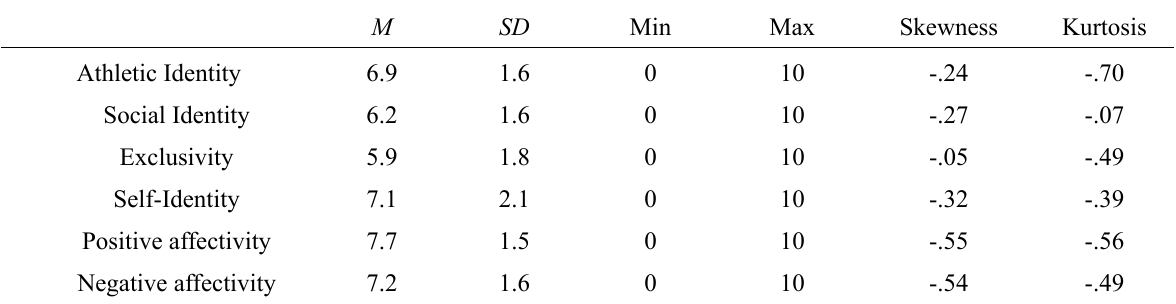
Descriptive Statistics for AIMS-plus (N=650)